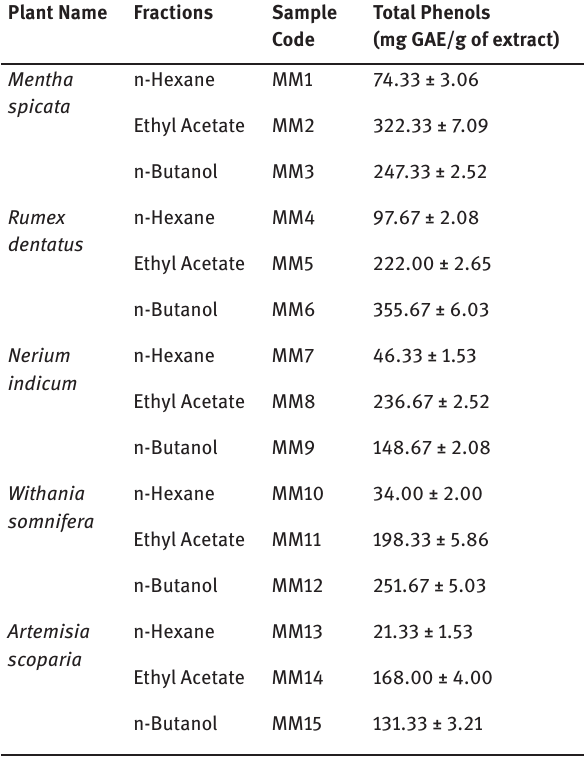
Table 1: Total Phenolic Contents of Selected Plants.